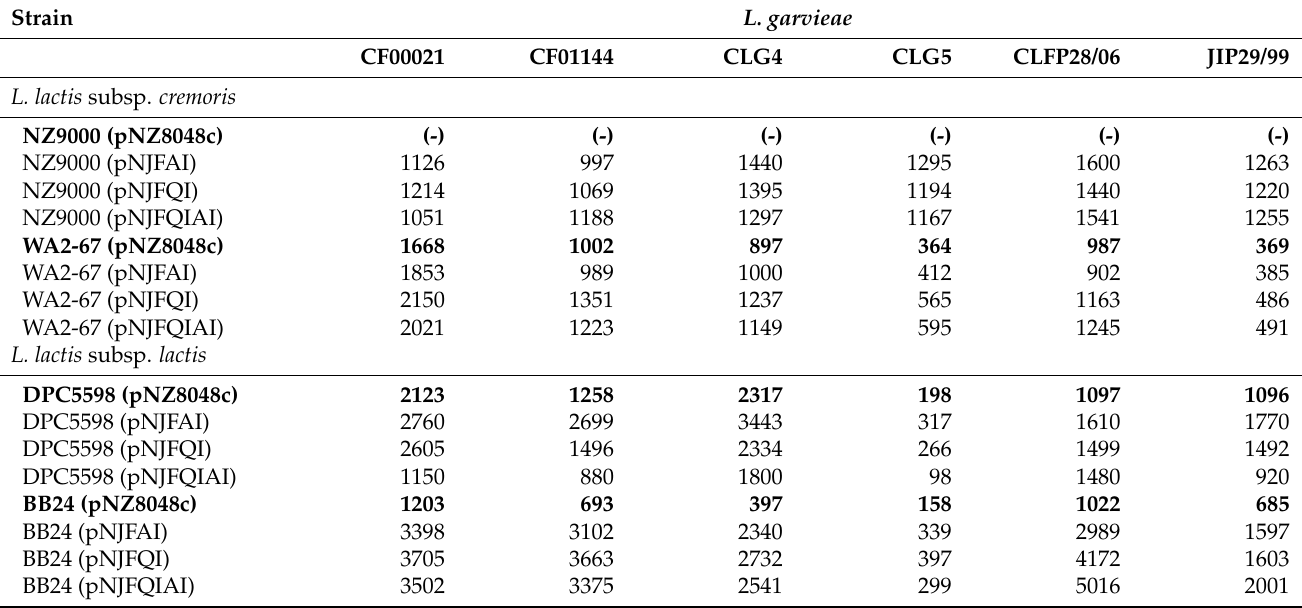
Table 4. Antimicrobial activity a of supernatants from recombinant L. lactis strains transformed